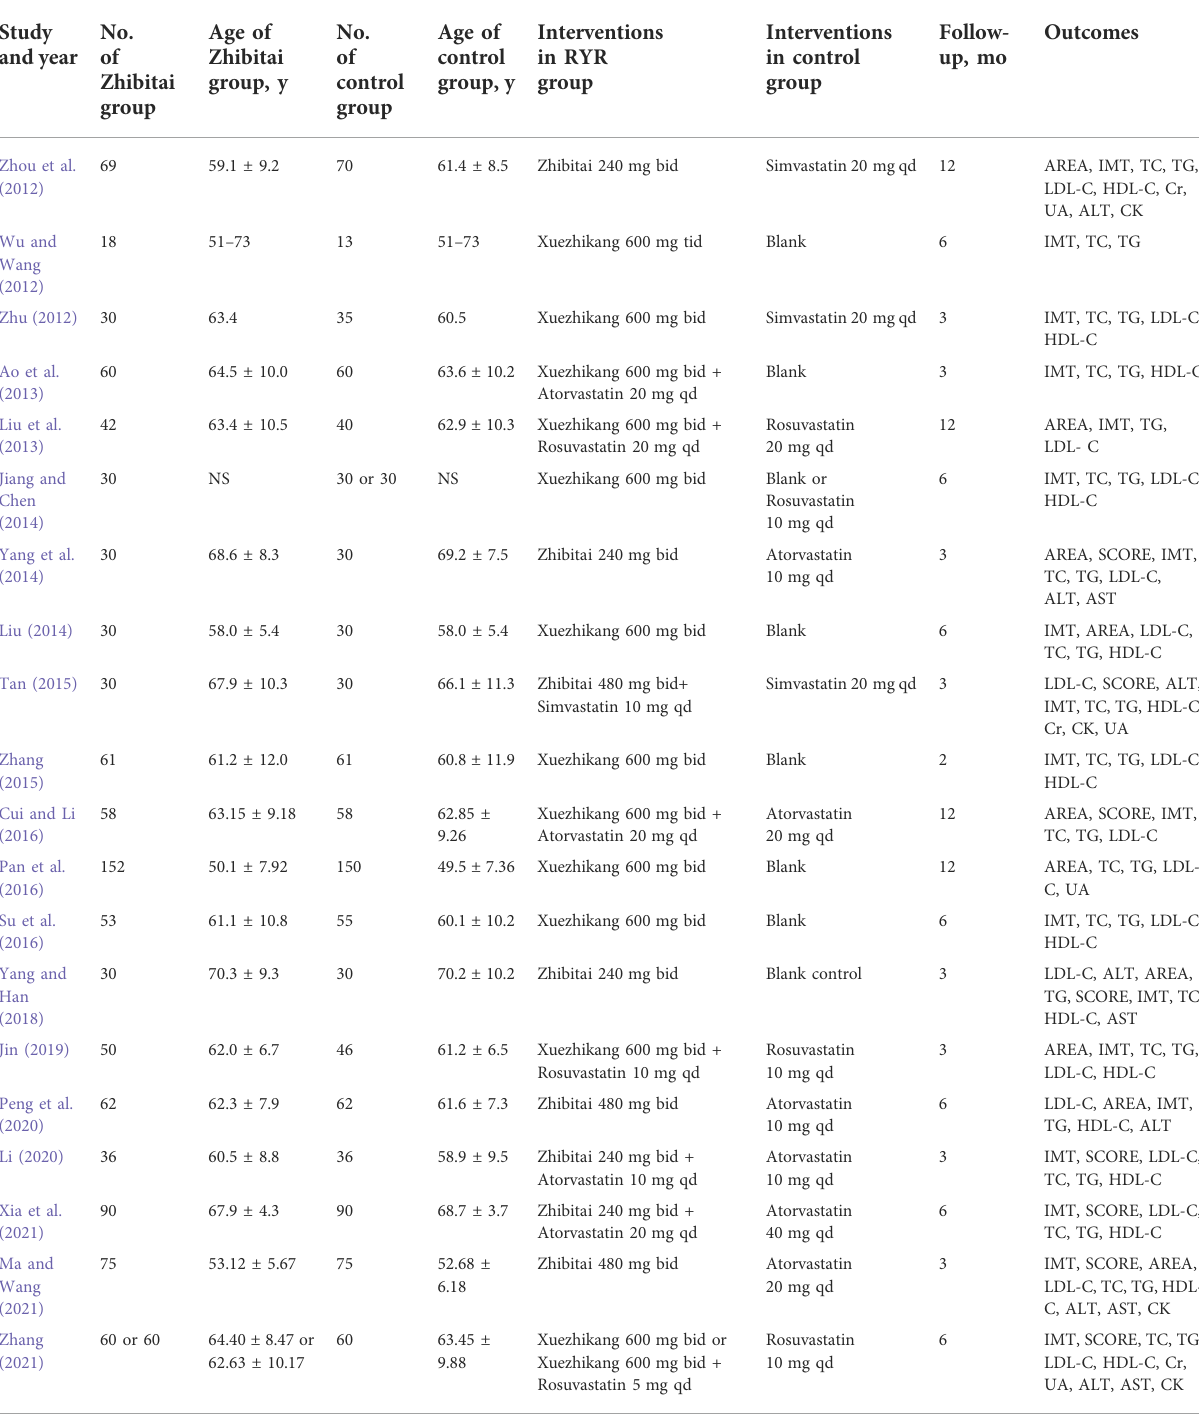
TABLE 1 General characteristics of the included studies. Study No. and year